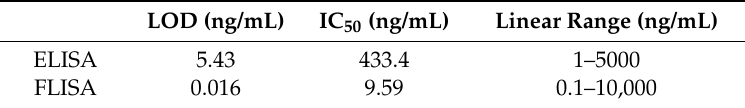
Table 1. Comparison of several parameters of the competitive FLISA and ELISA for RU.